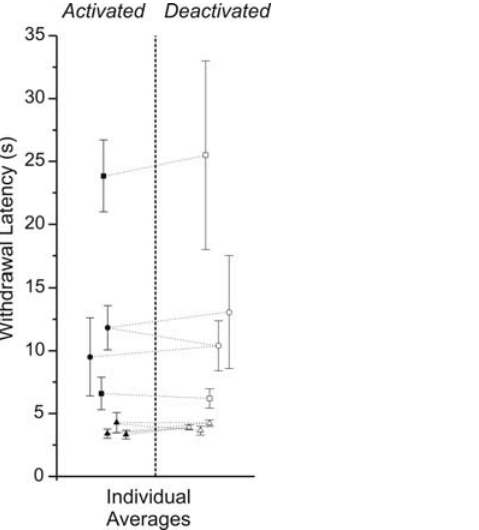
Figure 3. Anaesthetic level was comparable across state alternations. A) Individual (paired for animals across states by symbol) and overall averages of withdrawal latency across activated and deactivated states in response to a ramped infrared beam applied to the tail or hindpaw. Withdrawal latencies were comparable across states and neither the individual nor overall averages weresignificantly different.